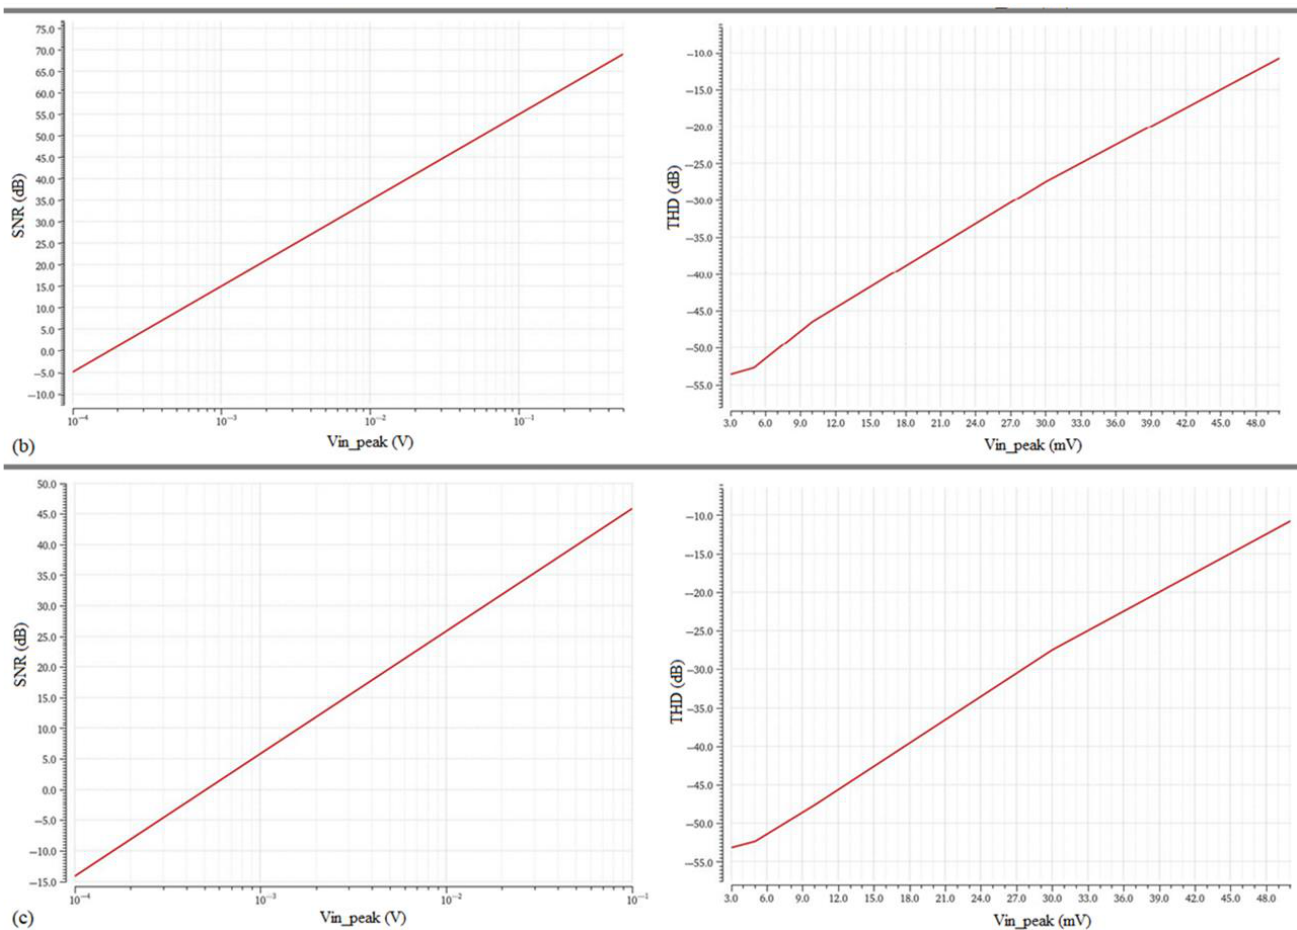
Figure 13. Signal-to-Noise Ratio (SNR) vs. V in_peak and Total Hamonic Distortion vs. V in_peak for the ( a ) R replacement, ( b ) L replacement, and ( c ) C replacement cascaded bandpass filter configuration. In Figure 14, the THD and SNR plots versus V in_peak for the leapfrog technique are depicted. From the diagrams in Figures 13 and 14, the values that appear on Table 8 are extracted.